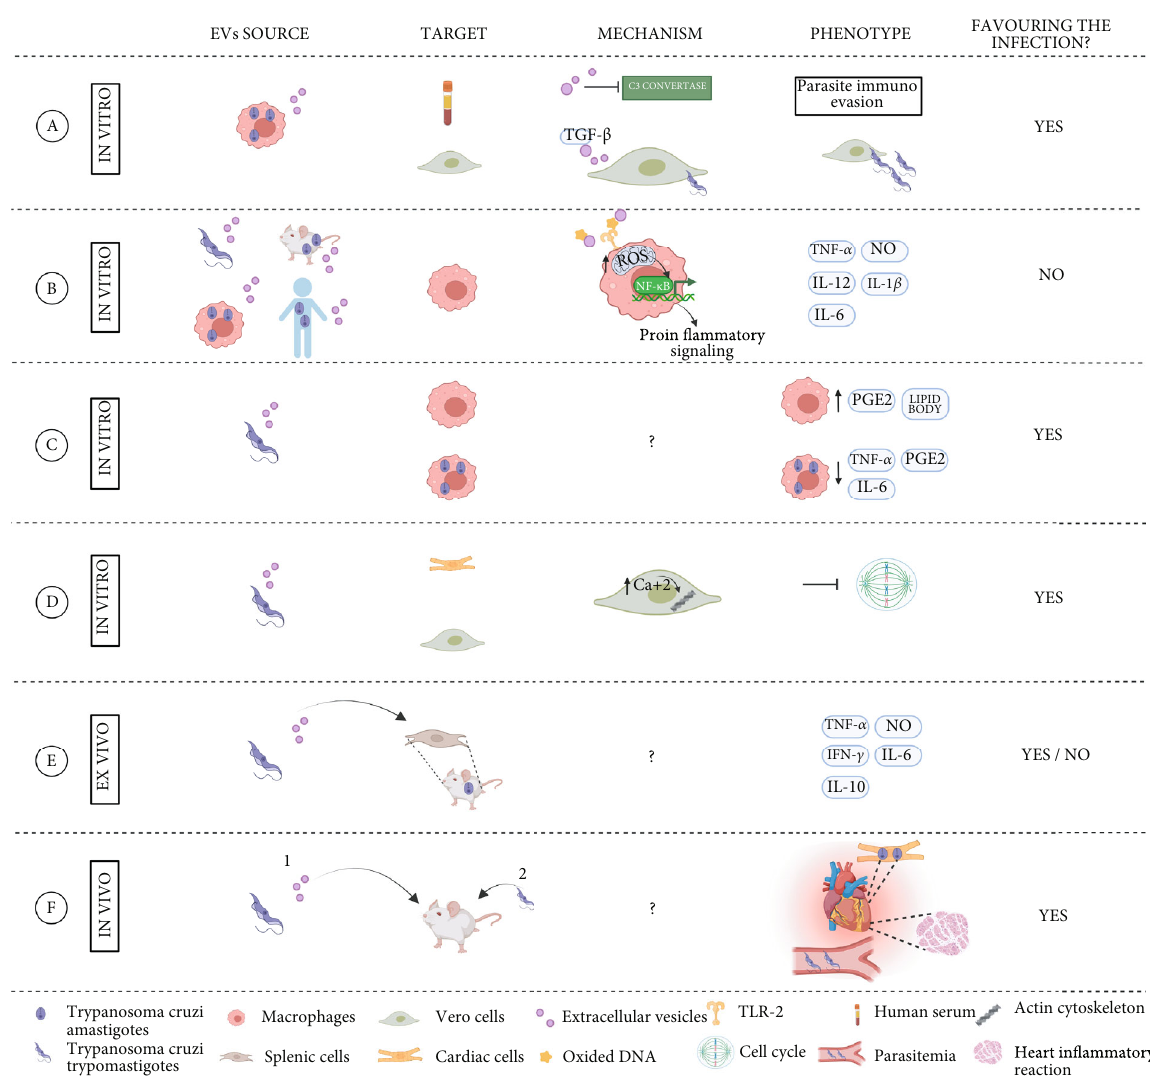
Figure 2: Immunomodulatory role of extracellular vesicles derived from T. cruzi and T. cruzi -infected cells. Summary of the main studies targeting the immunomodulatory e ff ect of EVs in T. cruzi infection: EV source, target cell or body fl uid, mechanism of action (if known), phenotype, and fi nal e ff ect on the infection process. (a) EVs secreted by infected macrophages can inhibit the C3 convertase, protecting the parasite against the complement system and increasing its chances of survival, and promote rapid cell invasion. (b) EVs from T. cruzi trypomastigotes, infected cells, infected individuals, and infected mice are recognized by uninfected macrophages via TLR2, inducing the translocation of NF- κ B and modulating the synthesis of proin fl ammatory cytokines. (c) T. cruzi EVs induce the formation of lipid body and PGE2 in noninfected macrophages and downregulate the synthesis of TNF- α , PGE2, and IL-6 in infected macrophages. (d) EVs secreted by the parasite alter cell permeability and intracellular levels of calcium in nonimmune host cells, modifying the dynamics of the cytoskeleton and arresting the cell cycle. (e) EVs secreted by trypomastigotes induce an ex vivo production of pro and anti-in fl ammatory cytokines in splenic cells from chronically-infected mice. (f) In vivo studies in mice, injected with trypomastigotes-derived EVs prior to T. cruzi infection, have shown an increase of circulating EVs in plasma and parasitemia, cardiac tropism, and in fl ammation (created with